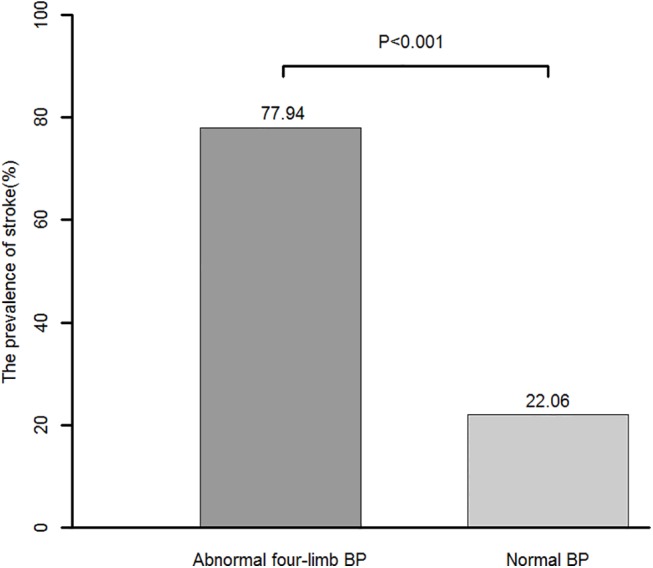
Abnormal four-limb blood pressure (BP) measurements and prevalence of stroke.Numbers above the bars are the rates of prior stroke. The p-value for comparison between the two groups was determined using the chi-square test.